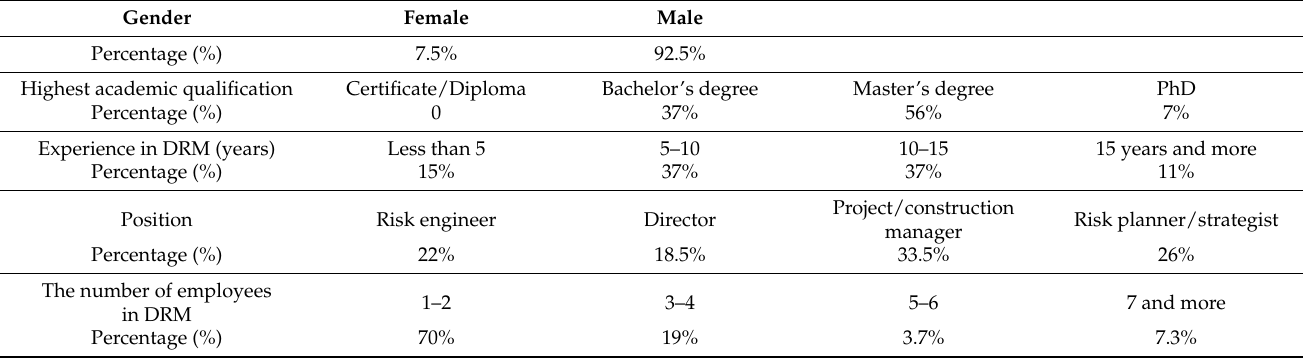
Table 2. Respondents’